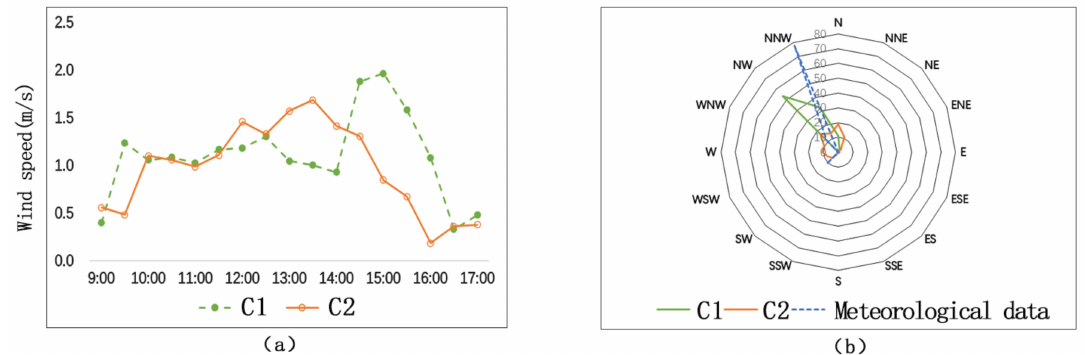
Figure 8. Comparison of wind speeds and wind direction frequencies of C1 and C2: ( a ) wind speeds; ( b ) wind direction